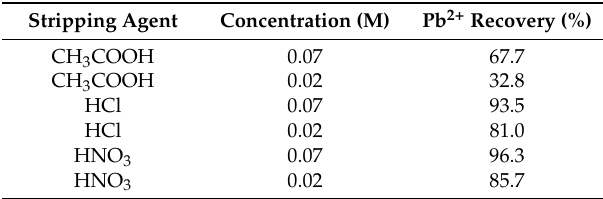
Table 3. Effect of stripping agents on Pb 2+ recovery 1 .